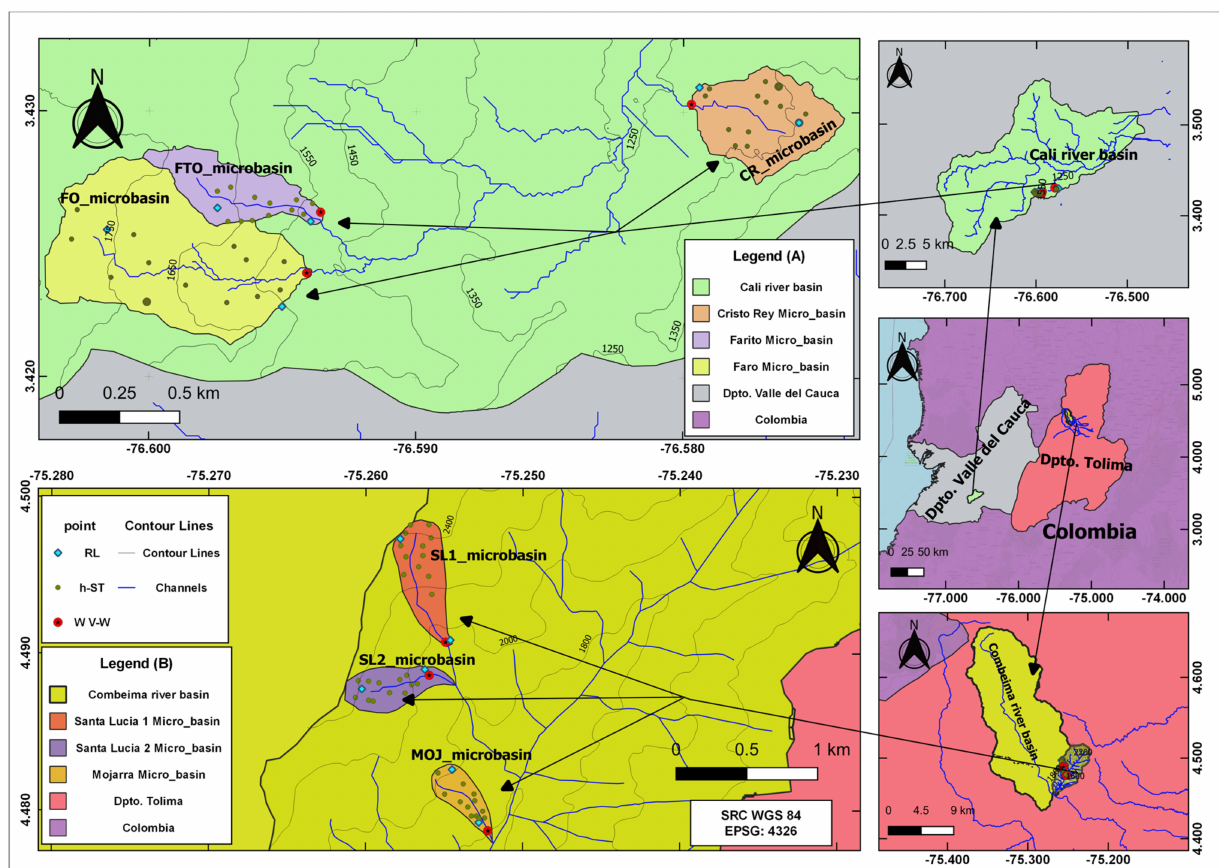
Figure 1. Location of the experimental microbasins FO, FTO, CR at Cali River basin ( A ) in the Valle del Cauca region; and SL1, SL2, MOJ at Combeima River basin ( B ) in the Tolima region. Measurement locations are indicated rain logger (RL), humidity site-tube (h-ST) and wall V-Weir (W V-W). (Microbasin is basically a watershed or hydrographic–hydrologic unit of a small drainage area. In some cases it is referred to in English as microcatchment, being preferable the expression “small watershed or small catchment”, according to Haan et al. [27]. It can be homologated in the same way as some hydrologists have indicated in terms of headwater (Haigh et al. [28], Haan et al. [27], as basins of zero order, based on the criterion of order number, delivery network and/or formation of the drainage